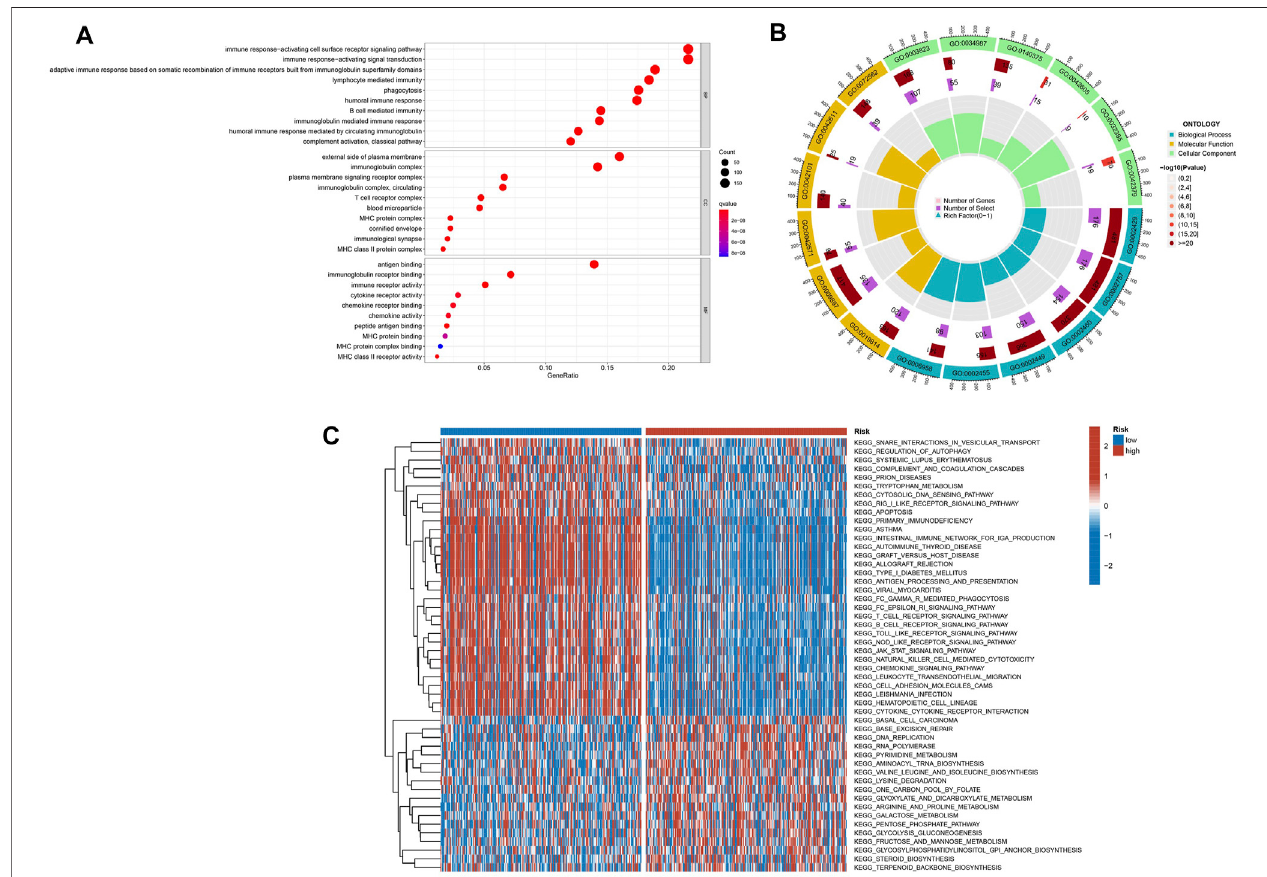
FIGURE 6 | The enriched items in functional analysis. (A,B) Gene ontology (GO) enrichment analysis. (C) KEGG pathway enrichment by GSVA between two risk subgroups.